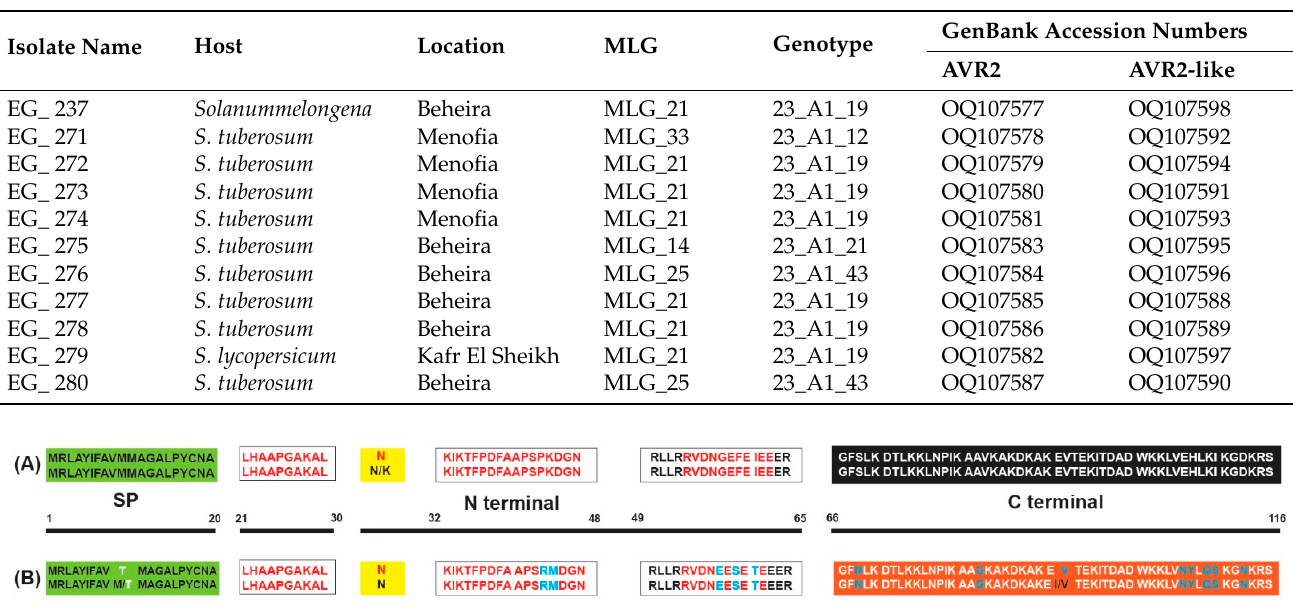
Table 2. Accession numbers and details of 11 isolates of P. infestans and their host.